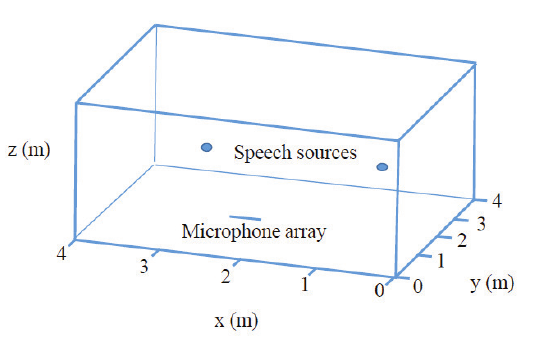
Figure 1. Setup of acoustic room and layout of microphone array for the indoor BSS. Figures 2 and 3 show the convergence for (i) the steepest descent, (ii) the accelerated gradient, and (iii) the accelerated conjugate gradient algorithms for the case with 0 dB and 10 dB SNR, respectively. All algorithms have optimal step size in each iteration and converge with (cid:101) = 2 × 10 − 3 = 0.002 in (13); moreover, we set the constant ρ as ρ = 1.1 and allow the unmixing weight matrices V ( k ) to have a cost function up to 10% larger than the cost of the unmixing weight matrices W ( k ) .